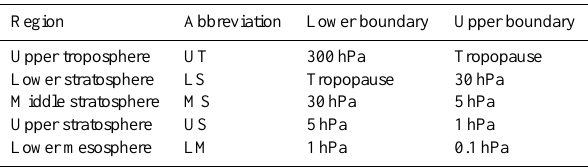
Table 3. Definitions and abbreviations of different atmospheric re- gions used for the